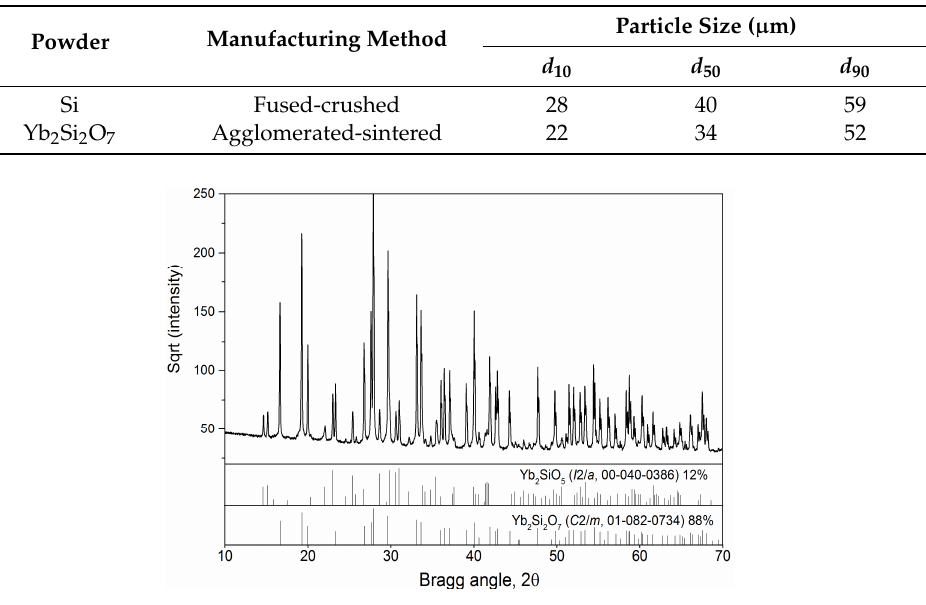
Figure 1. X ‐ ray diffractogram of the Yb 2 Si 2 O 7 feedstock. Figure 1. X-ray diffractogram of the Yb 2 Si 2 O 7 feedstock. Table 2. HVOF spray parameters for processing Yb 2 Si 2 O 7 coatings. Table 2. HVOF spray parameters for processing Yb 2 Si 2 O 7 coatings.